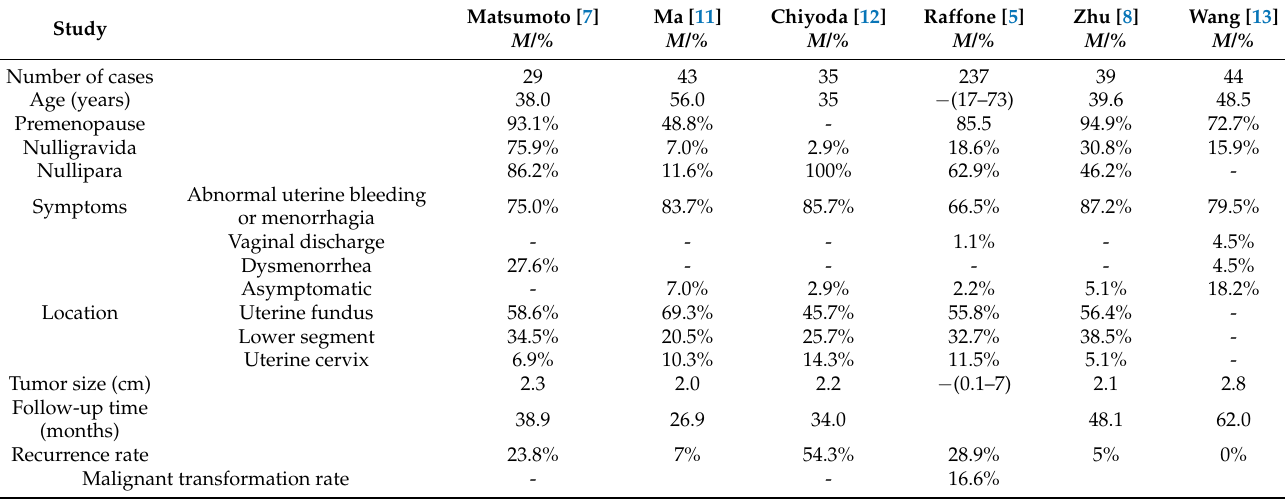
Table 3. Case reviews of